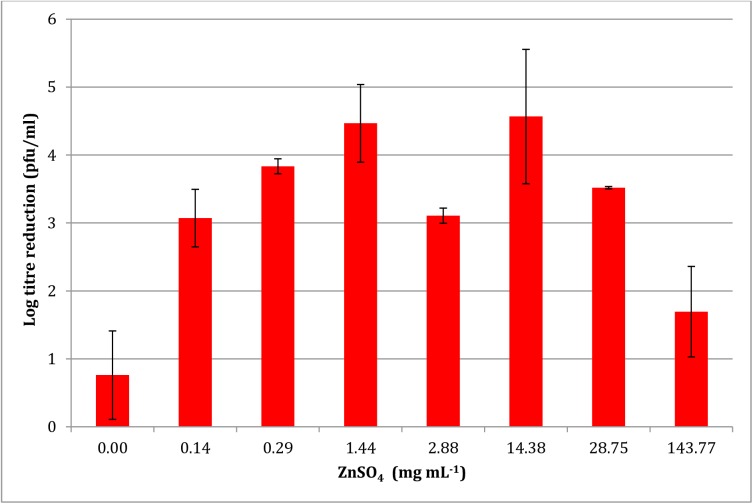
Effect of ZnSO4 concentration on the potentiated virucidal activity of PRE (0.05 mg mL-1) (n = 4 ± SD).Results show an increase in potentiated activity up to 1.44 mg mL-1; thereafter the pattern is unpredictable, and generally decreases with higher zinc levels.